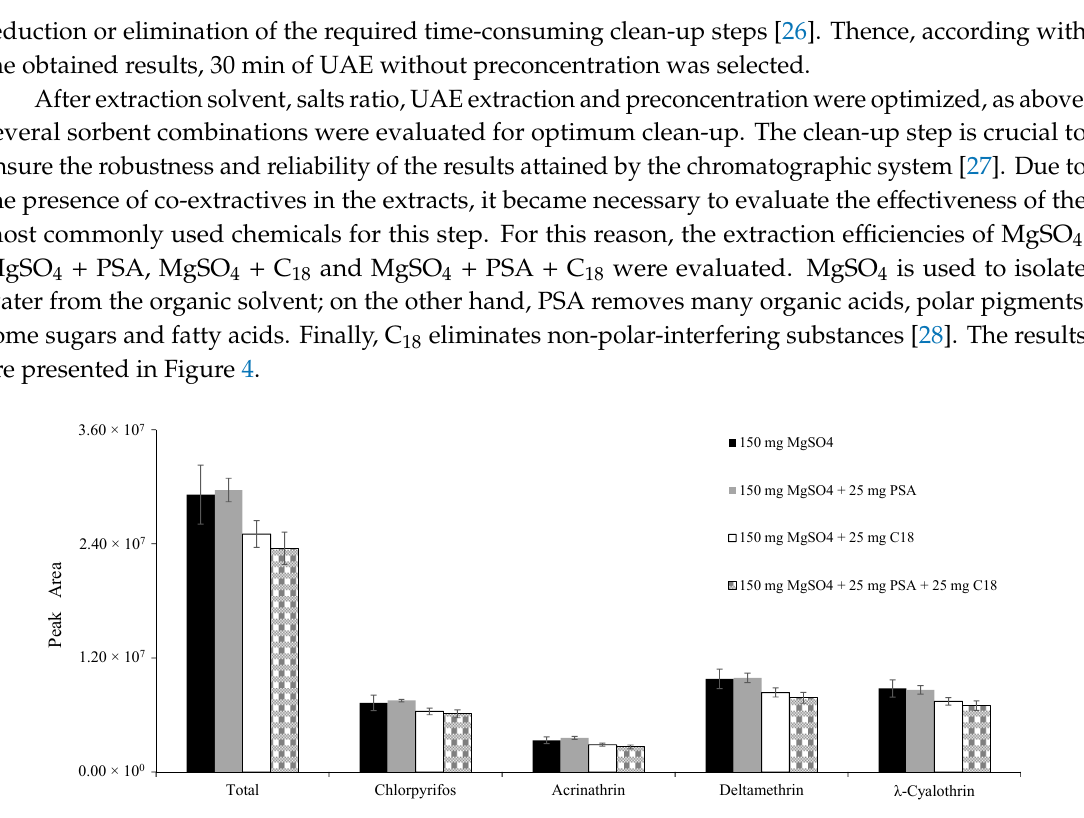
Figure 4. Influence of commonly used clean ‐ up salts, evaluated for their effectiveness on insecticides analysis.